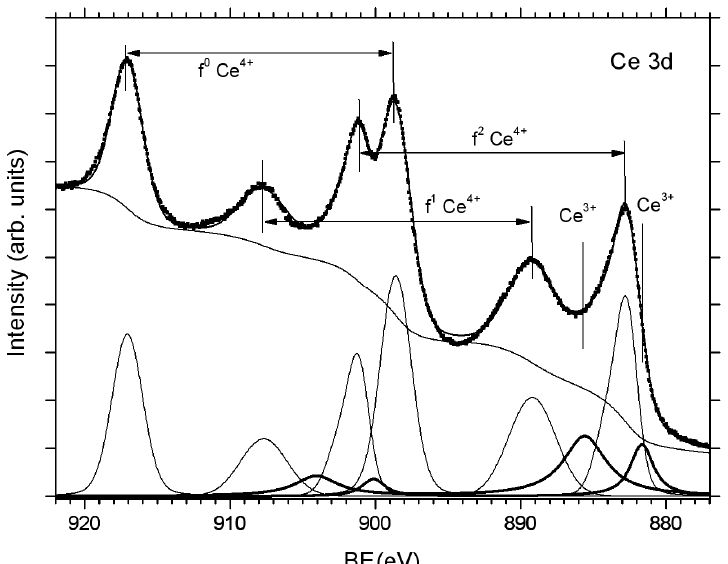
Figure 2. XPS Ce 3d spectrum of partially reduced cerium oxide obtained using Al K α laboratory X-ray source (1486 eV). Decomposition of the Ce 3d spectrum yields background contribution (monotonously decreasing curve), spectral peak belonging to Ce 4+ doublets (thin lines) and to Ce 3+ doublets (thick lines).